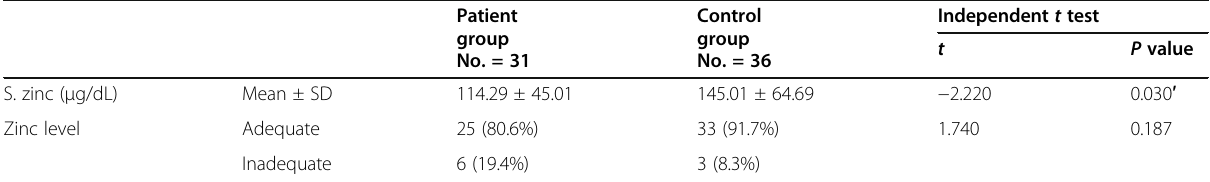
Table 5 Serum zinc level and comparison to normal range